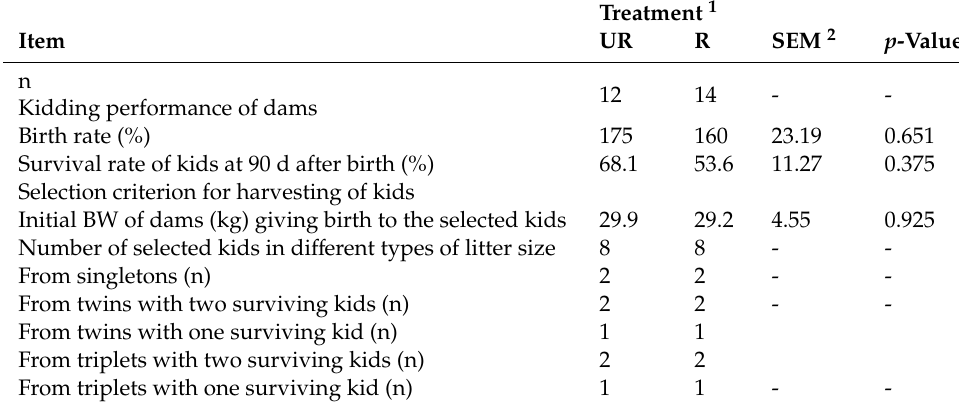
Table 2. Kidding performance of dams and selection criterion for harvesting of